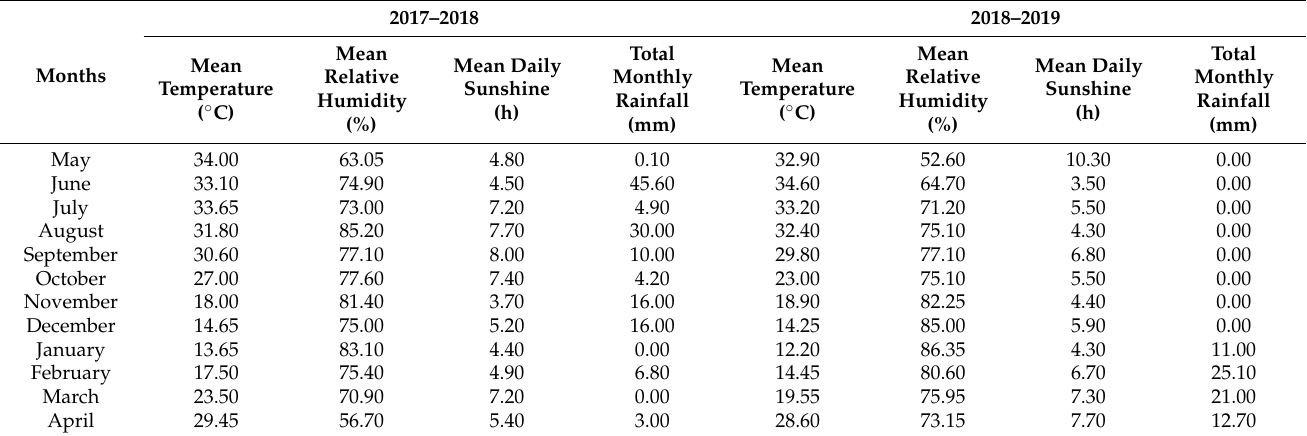
Table 8. Weather data for the period of research at the experimental